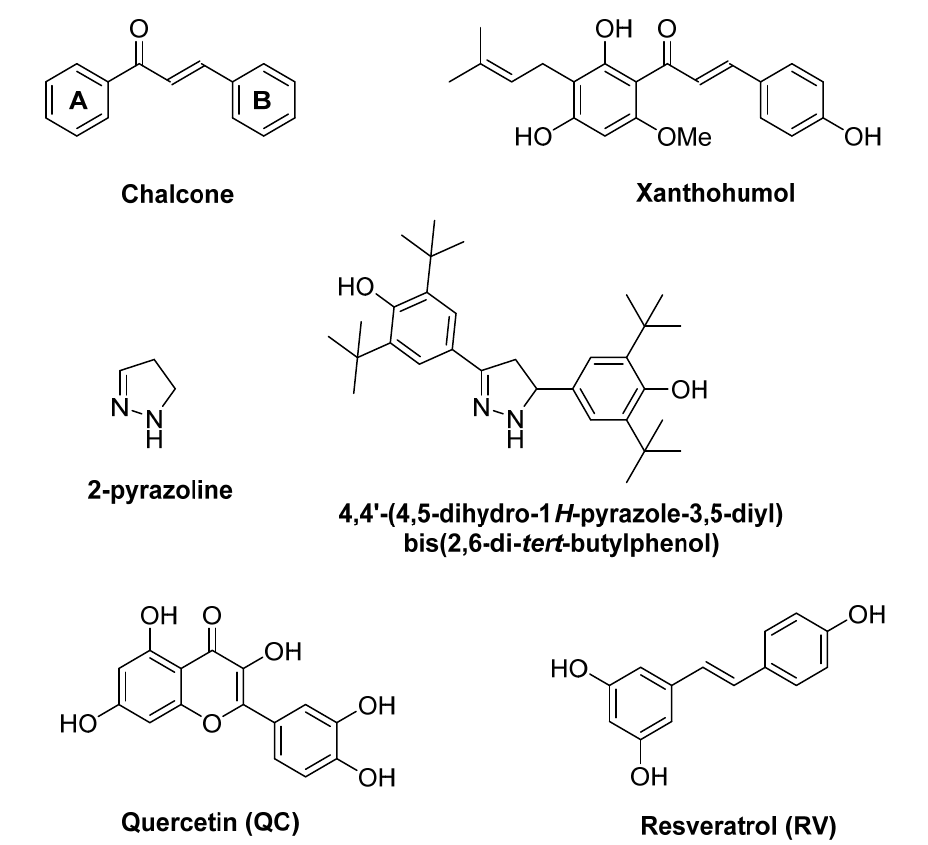
Figure 1. Chemical structures of some biologically active compounds.